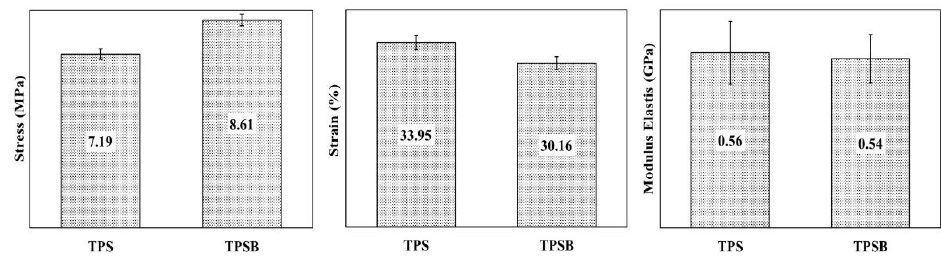
Figure 5. Mechanical properties of TPS and TPSB.